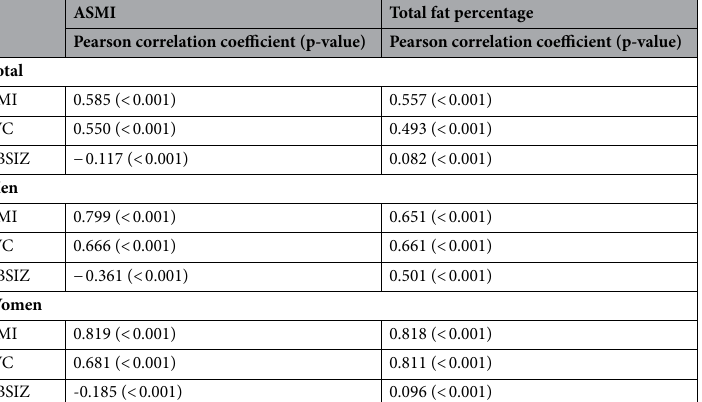
Table 2. Correlation between obesity parameters with body composition (N-11780). BMI body mass index, WC waist circumference, LBSIZ z-score of the log-transformed A Body Shape Index, ASMI appendicular skeletal mass index.